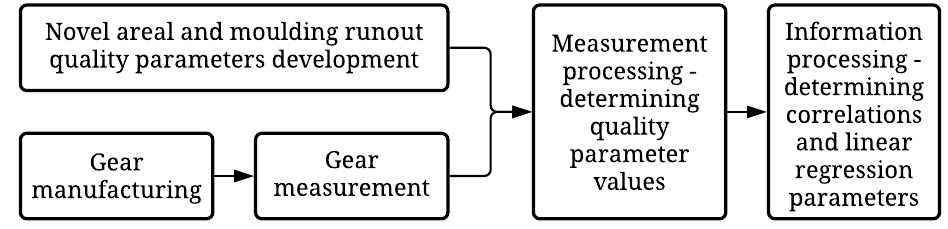
Figure 1. Research process of the